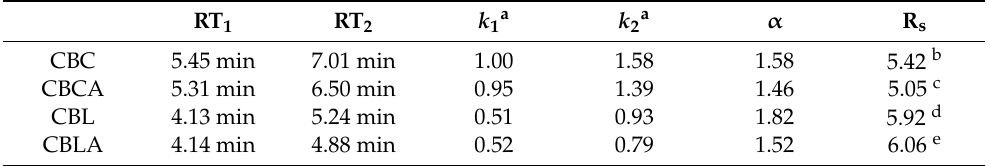
Table 5. Chromatographic performance of preparative cannabinoid separations on IK with